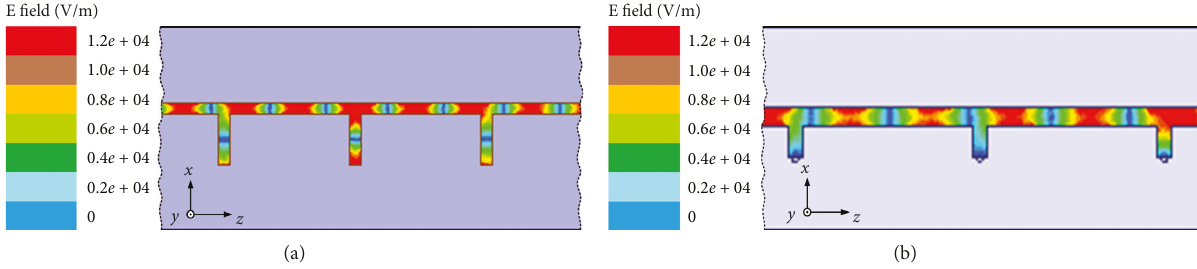
Figure 3: Electric-field distributions of the miniaturized and whole-width MLWA at 9GHz. (a) Whole width; (b) miniaturized.